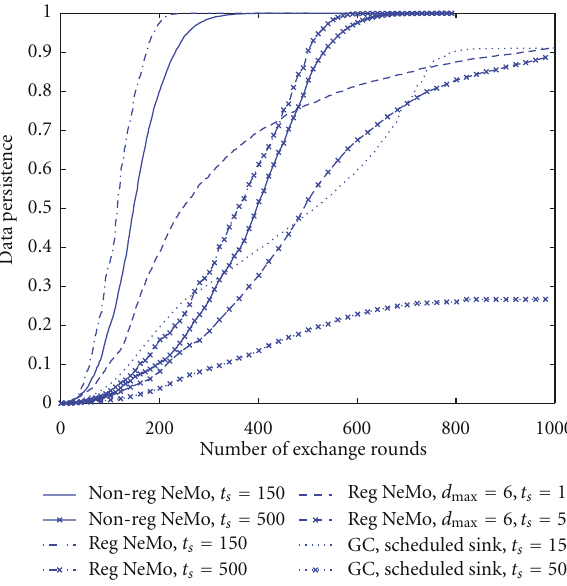
Figure 4: The e ff ects of